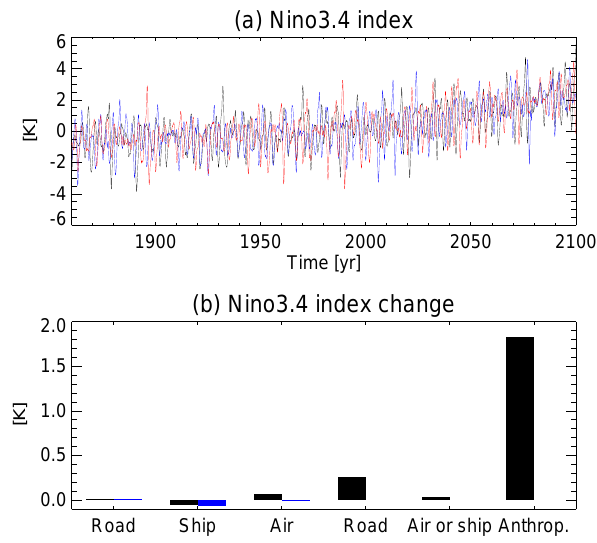
Fig. (a) Evolution of the Ni˜no 3.4 index anomaly over the 1860–2100 period for the 3 simulations forced by the total anthro- pogenic forcing (reference value calculated as the ensemble mean over 1971–2000). (b) Mean impact on the Ni˜no 3.4 index of the dif- ferent transport sectors over 2050–2099: the first three bars indicate the non-CO 2 impact (black for the dynamic O 3 approach, blue for the fixed O 3 approach), the following two bars the CO 2 impact, and the last bar the total anthropogenic impact.